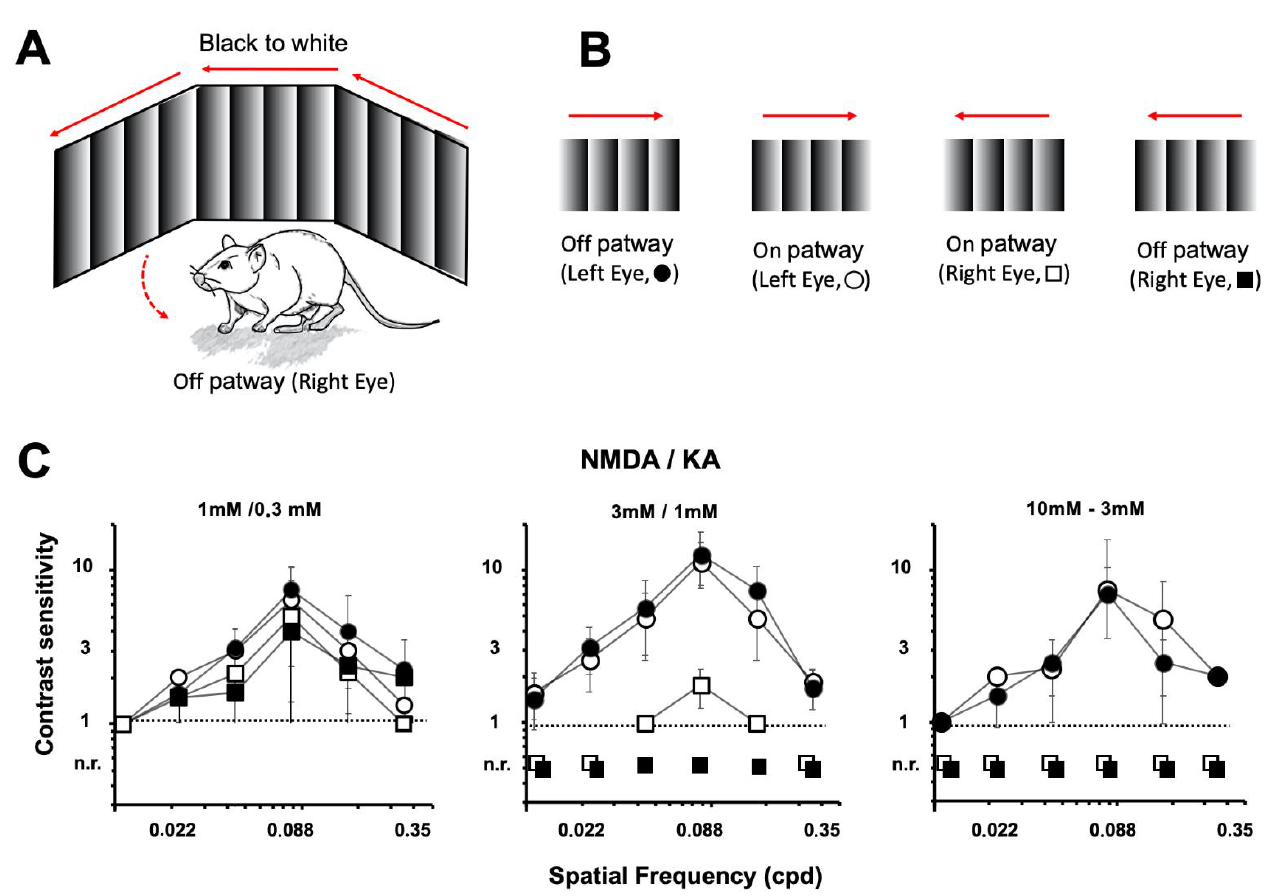
Figure 8. Effect of NMDA/KA injection on visual acuity. Optomotor test evaluation of visual acuity (contrast sensitivity) in experimental animals injected intraocularly into the right eye with NMDA/KA (1:0.3 mM, n = 7; 3:1 mM, n = 7; and 10:3 mM, n = 4). The control left eye is injected with PBS. ( A ). Schematic diagram of the optomotor test experimental design. ( B ). The OFF visual pathway is tested by vertical bars with a horizontal gradient from white to black (closed symbols). The ON visual pathway is tested by vertical bars with a horizontal gradient from black to white (open symbols). Clockwise (circles) and counterclockwise directions (squares) are tested. The spatial frequencies of the moving visual stimuli are tested at different spatial frequencies. ( C ). Animals fail to follow the visual stimulus in an anticlockwise direction (mediated by the injured right eye), when compared with the clockwise response (mediated by the control left eye) as a result of NMDA/KA excitotoxicity at 3:1 mM or 10:3 mM ( p < 0.05, two tail ANOVA). For 3:1 mM NMDA/KA injection, animals are still able to detect light stimuli mediated by the ON pathway, while the OFF pathway is completely insensitive (n.r.—no response to stimuli).